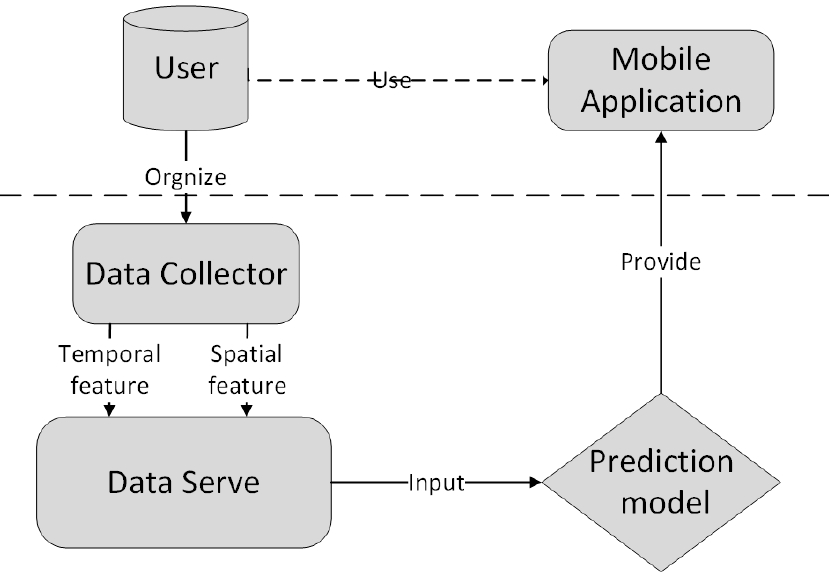
Figure 12. Software architecture diagram.